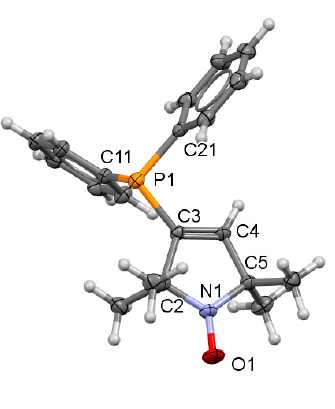
Figure 2. Ortep style view of 8 with a partial numbering scheme showing thermal displacement ellipsoids drawn at the 50% probability level. Key bond lengths [Å] and angles [°] are P1-C3 1.827(2), P1-C21 1.835(2), P1-C11 1.827(2), N1-O1 1.271(3), C3-C4 1.322(3), N1-C2 1.480(3), N1-C5 1.476(3); O1-N1-C5 122.2(2), C5-N1-C2 114.94(18), C4-C3-P1 129.02(18), C2-C3-P1 119.46(17).